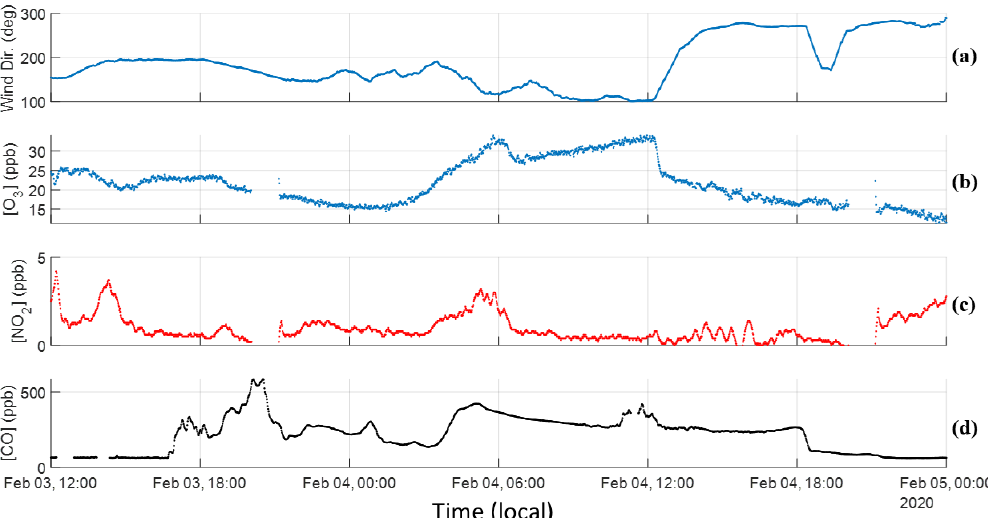
Figure 4. Time series for O 3 , NO 2 , CO, and wind direction. (a) Wind direction is read as true north is 0 ◦ and east is 90 ◦ . (b) O 3 trends well with CO until sunrise occurs, wherein BBVOC + OH oxidation combined with biogenic VOC emissions led to daily production. The close trend with CO over nighttime indicates transport rather than local formation. (c) NO 2 also shows a similar trend but upon sunrise begins to negatively correlate with CO and O 3 . (d) CO smoke tracer provided as time series